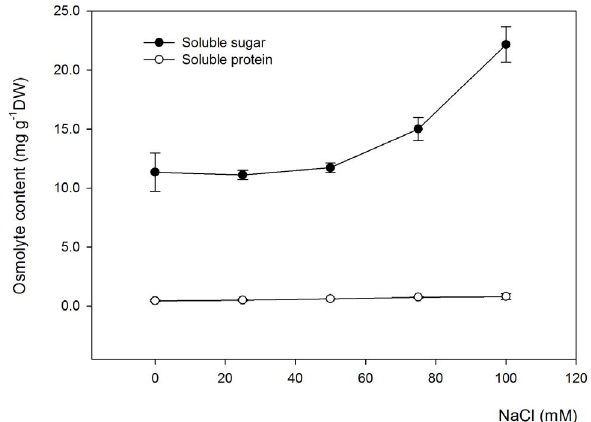
Figure 2. The effects of various NaCl concentrations on the enzyme activities of Salvia miltiorrhiza leaves. The enzyme activities measured in this experiment include superoxide dismutase (SOD) and catalase (CAT) activities. Salvia miltiorrhiza seedlings were cultivated in 1/2 Hoagland nutrient solution for 3 weeks and were later exposed to salt stress by adding NaCl to concentrations of 25, 50, 75 and 100 mM of the hydroponic solution for 30 days. Non-treated plants were used as controls (0 mM NaCl). Error bars represent the standard errors (SE) of the means.